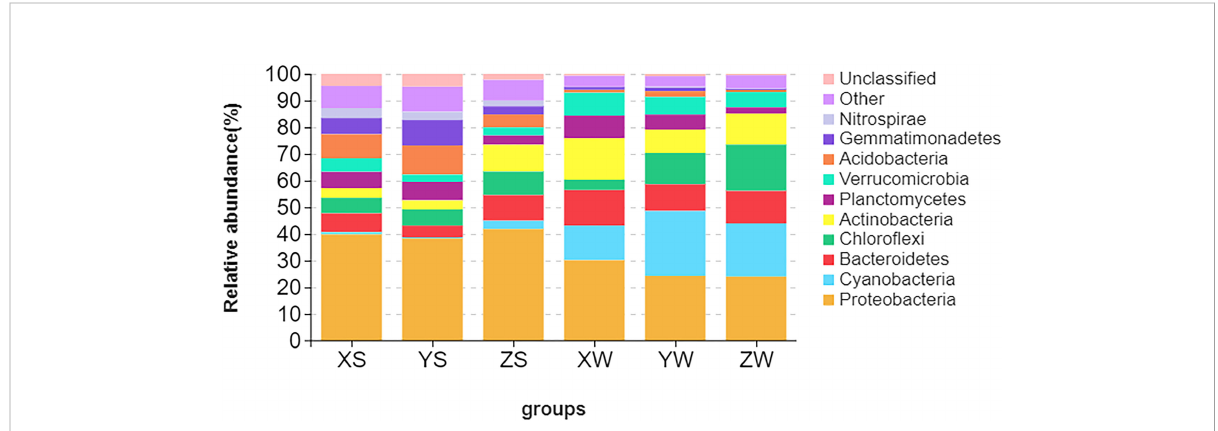
FIGURE 5 Relative abundance of the top 10 phyla in the water and sediment samples. X, Y, and Z indicate the fi ngerling, rearing, and harvesting stages, respectively, and S and W indicate the pond water and sediment samples,